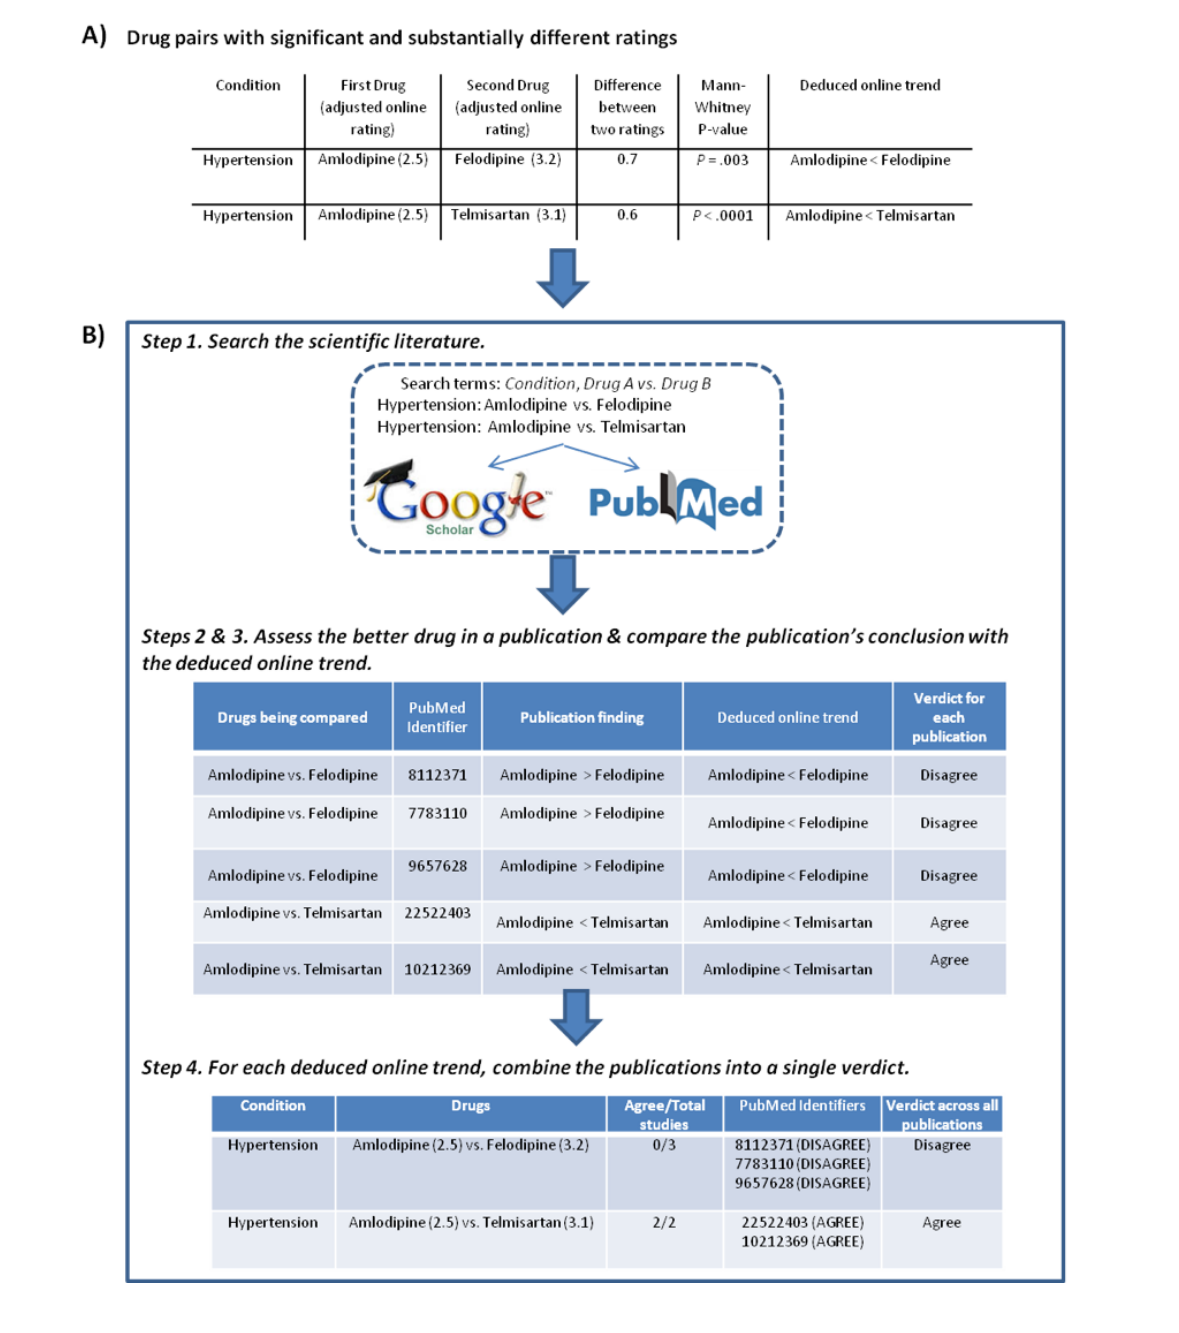
Figure 1. Examples of drug pairs with significant and substantially different ratings, and a procedure flowchart for comparing online findings with scientific